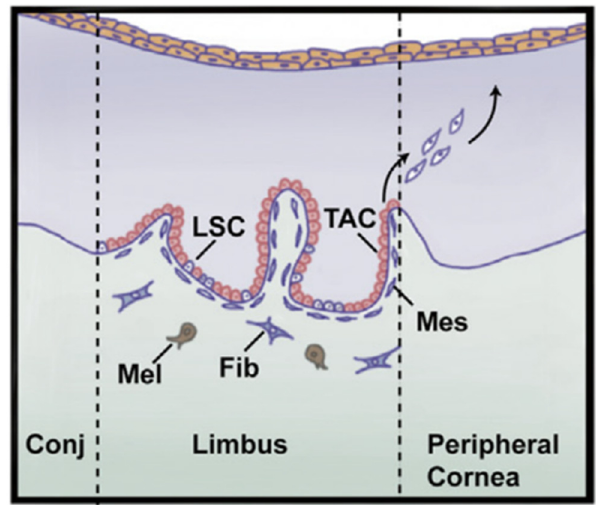
Figure 2. The major role of the limbus is to regenerate epithelium where the limbal stem cells (LSCs) reside. LSCs produce transient amplifying cells (TACs) that have a significant proliferation potential. Then, TACs migrate to epithelium which is responsible for producing epithelial cells and is replaced. Mes = mesenchymal cell, Mel = melanocyte, Fib = fibroblast, Conj = conjunctiva. Adopted and modified from [1] (Chapter 67) with permission.